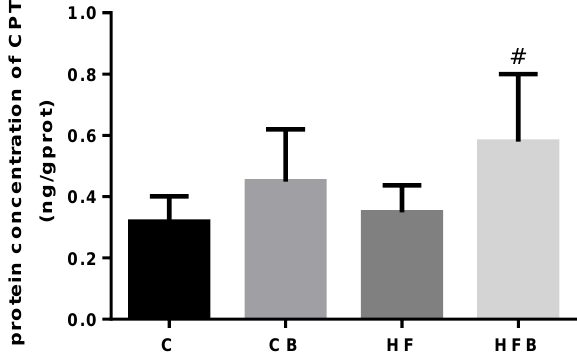
Figure 5. Effects of betaine and high-fat diet on concentration of CPT1 in the liver of rats ( n = 8): the concentration of hepatic Carnitine palmitoyl transferase1 (CPT1, BET, p = 0.002, FAT, p = 0.148, interaction, p = 0.361). # Significantly different from the HF group ( p < 0.05).